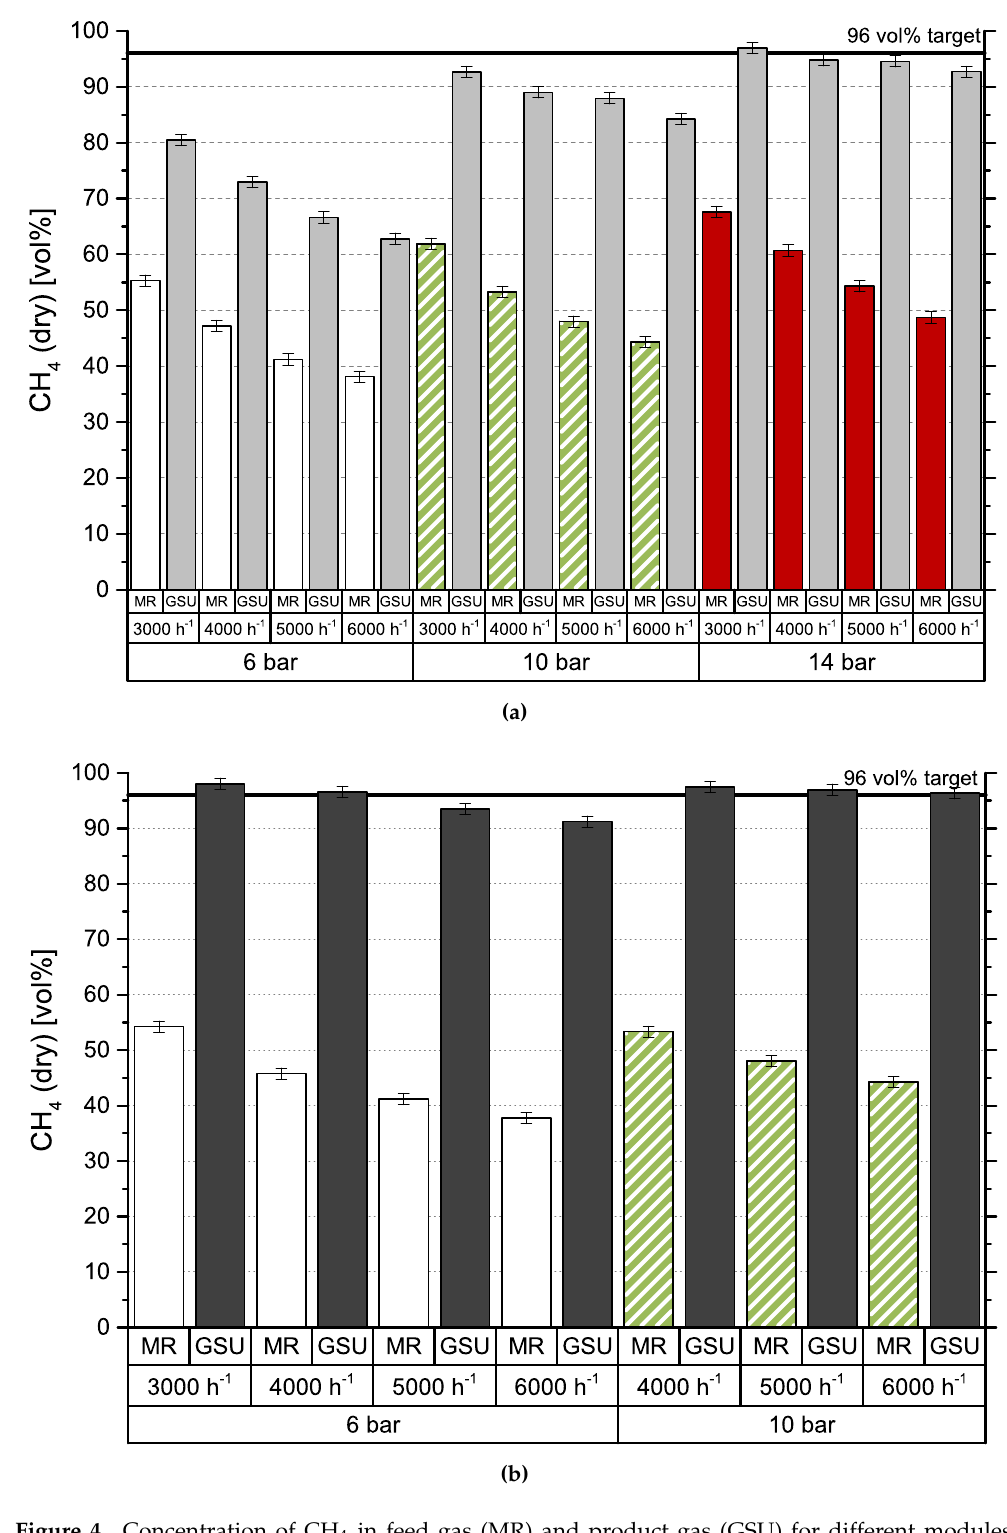
Figure 4. Concentration of CH 4 in feed gas (MR) and product gas (GSU) for different modules; ( a ) Module 1; ( b ) Module